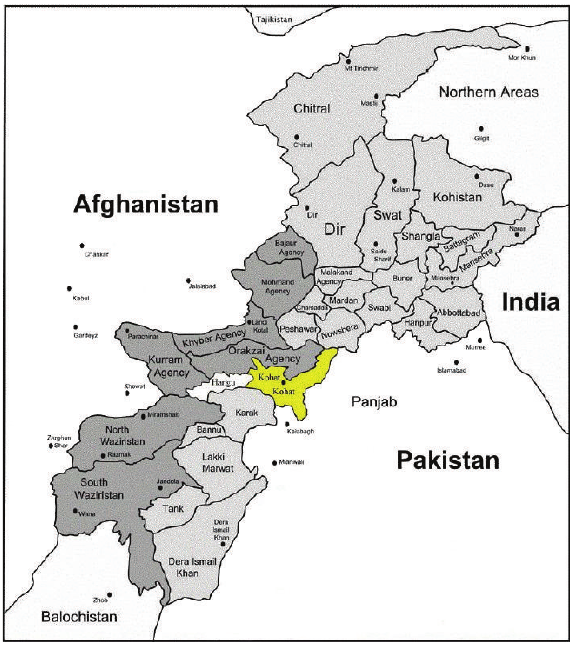
Figure 1: Study area